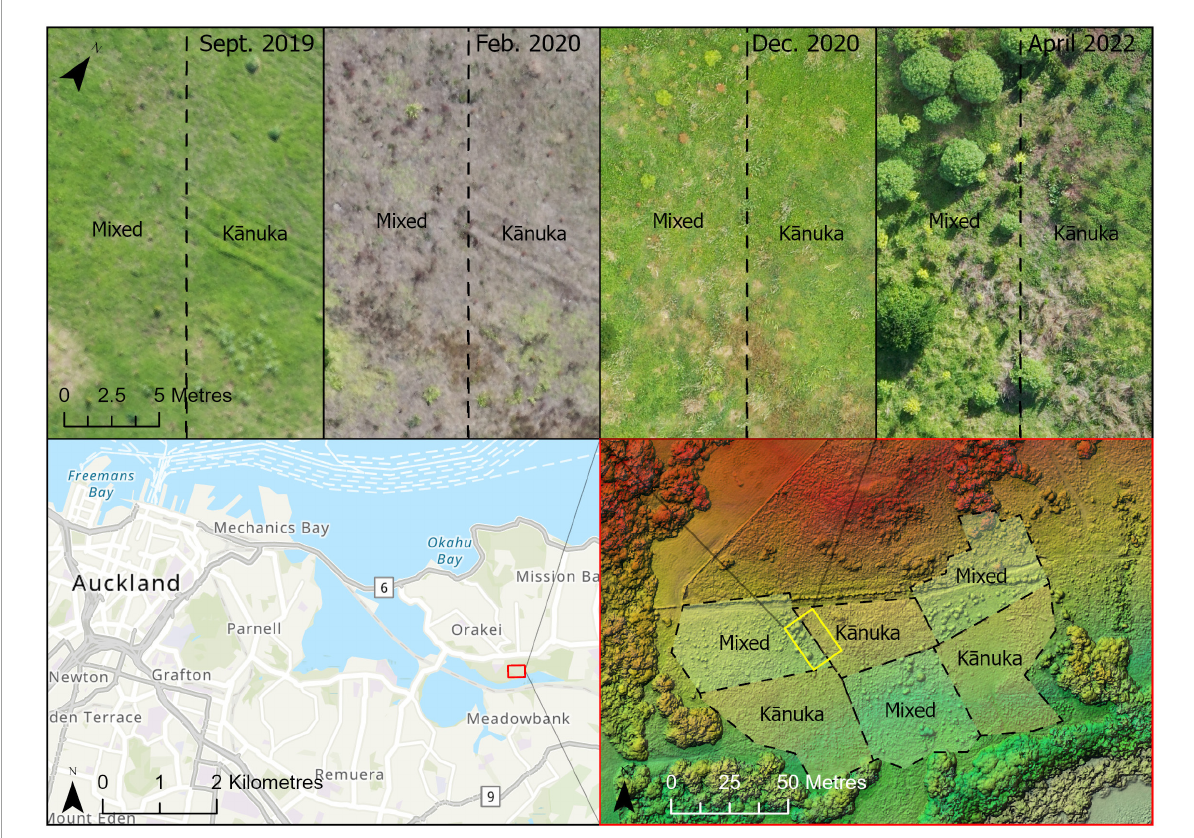
FIGURE3 An illustration, for the Pourewa experimental site, of the use of UAV (drone) captured imagery for site monitoring. In the (top) half of the figure, spatio-temporal variation in weedy vegetation (e.g., grass cover), drought effects (e.g., Feb 2020), and seedling growth can be tracked in different treatment blocks; note that seedlings have become visible in the 2022 imagery. The (bottom right panel) illustrates how photogrammetric techniques can be applied to the images to produce digital surface models (DSMs), capturing variation in topography, and in the taller vegetation where it exists, across the